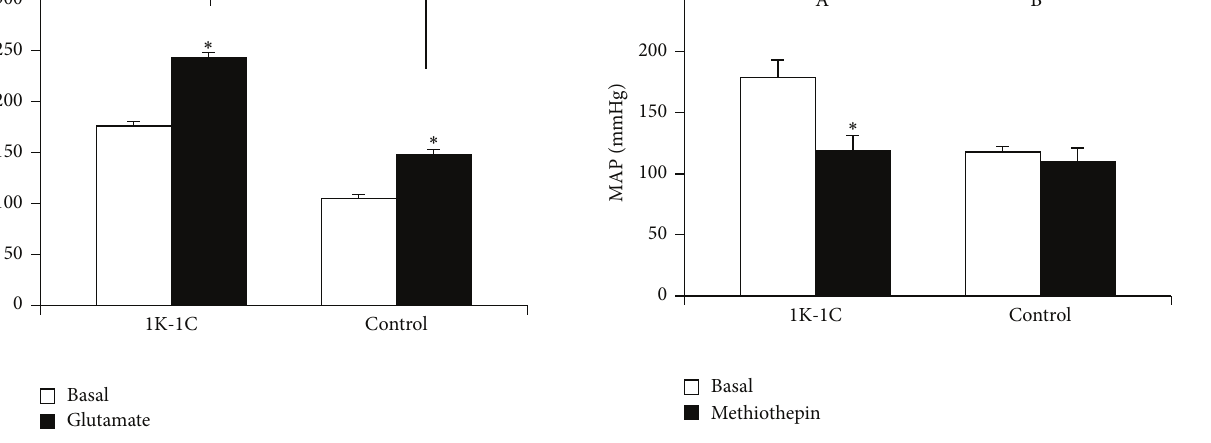
Figure 1: Values of mean arterial pressure (MAP) reached after bilateral microinjection of glutamate (0.1mol/L, 100 nL) into the RVLM in 1K-1C ( 𝑛 = 12 ) or control rats ( 𝑛 = 10 ). ∗ 𝑃 < .05 in relation to basal level and ∗∗ 𝑃 < .05 comparison between groups.